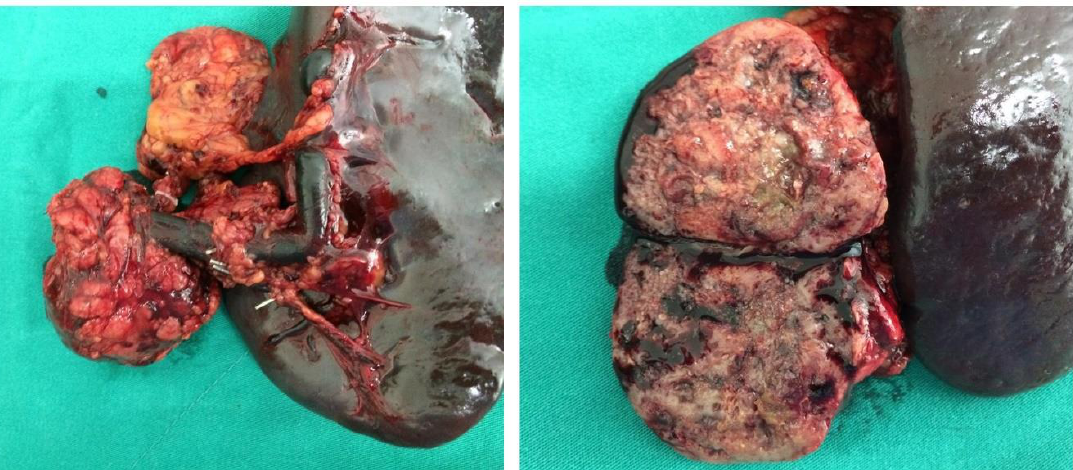
Figure 3. Macroscopic examination of the specimen of one of the reviewed cases, the product of a distal pancreatectomy: solid pseudopapillary neoplasm with areas of necrosis and hemorrhage, well delimited to the pancreatic